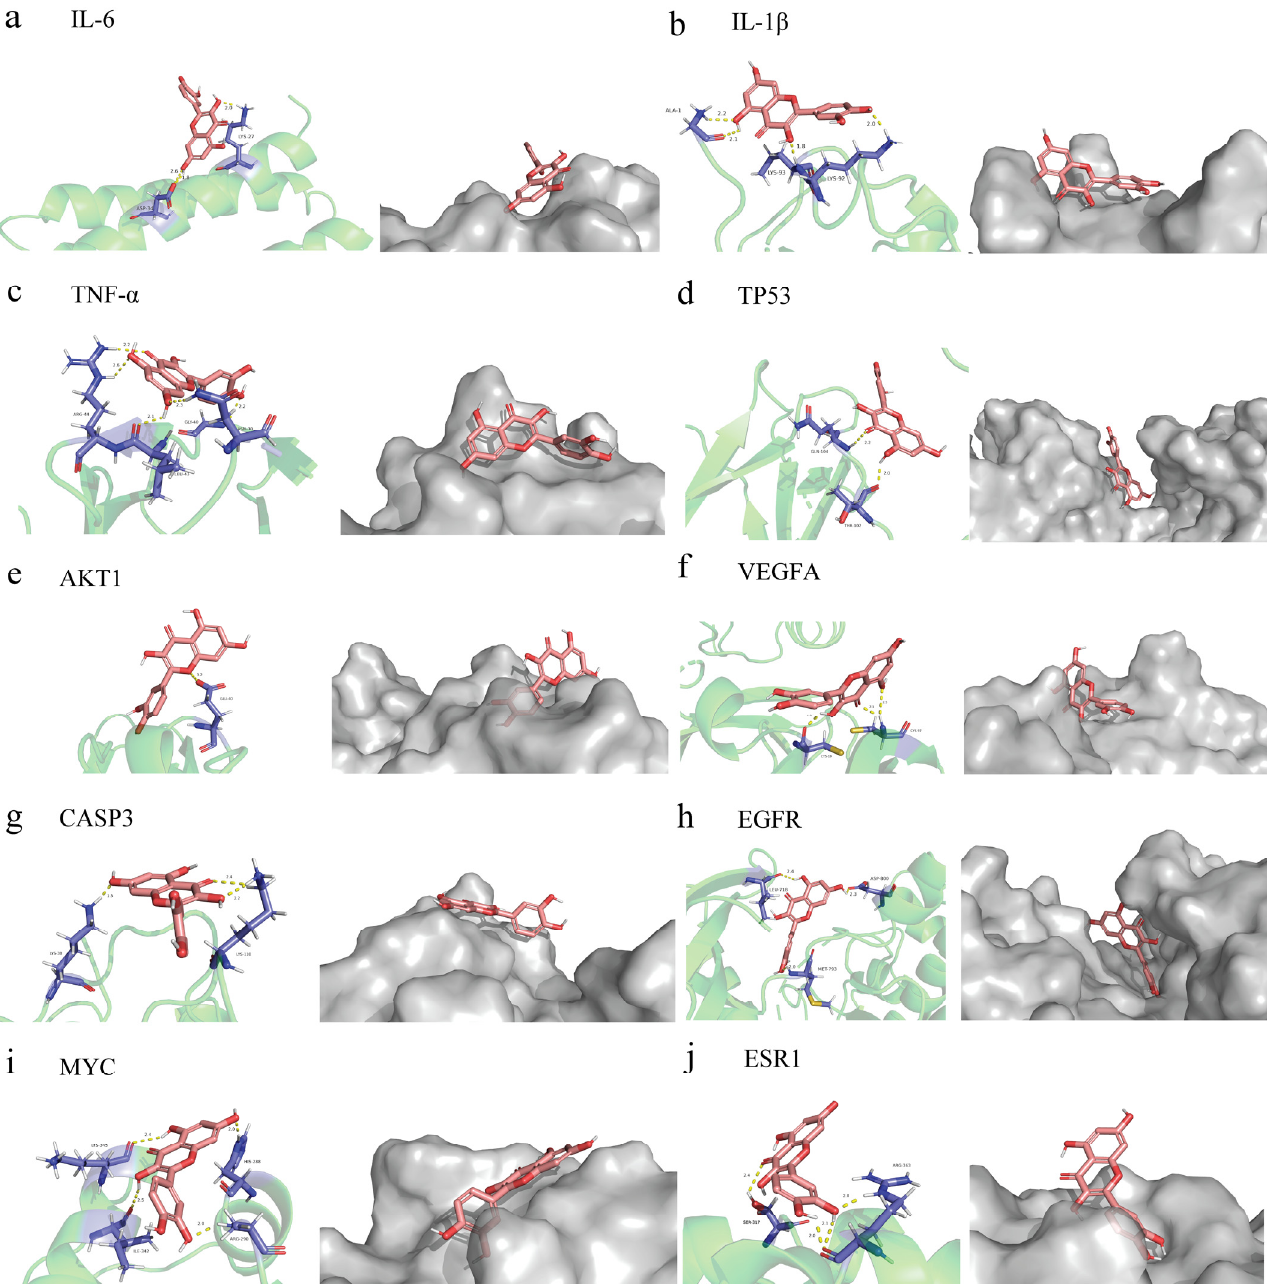
Figure 4. Partial diagram of molecular docking of quercetin with the following targets. ( a ) IL-6-quercetin; ( b ) IL- β -quercetin; ( c ) TNF- α -quercetin; ( d ) TP53-quercetin; ( e ) AKT1-quercetin; ( f ) VEGFA- quercetin; ( g ) CASP3-quercetin; ( h ) EGFR-quercetin; ( i ) MYC-quercetin; ( j ) ESR1-quercetin.